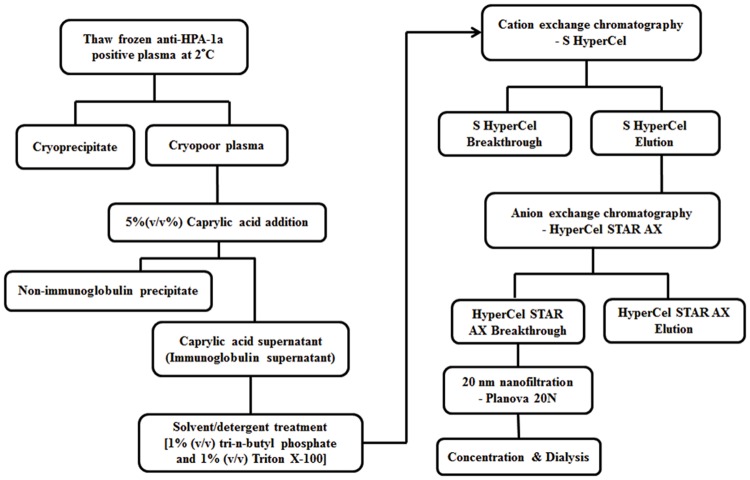
Fractionation scheme of plasma for the preparation of anti-human platelet antigen (HPA)-1a immunoglobulin G.